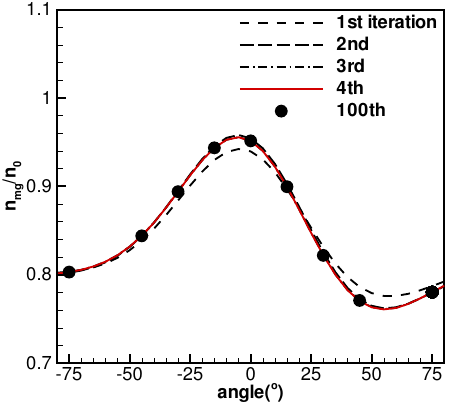
Figure 17. Test case: mixture centerline number flux nV / ( n 0